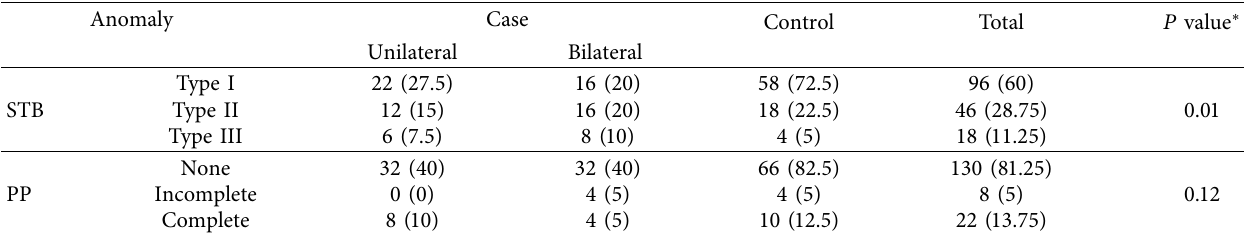
Table 2: Frequency (%) of STB and PP among study